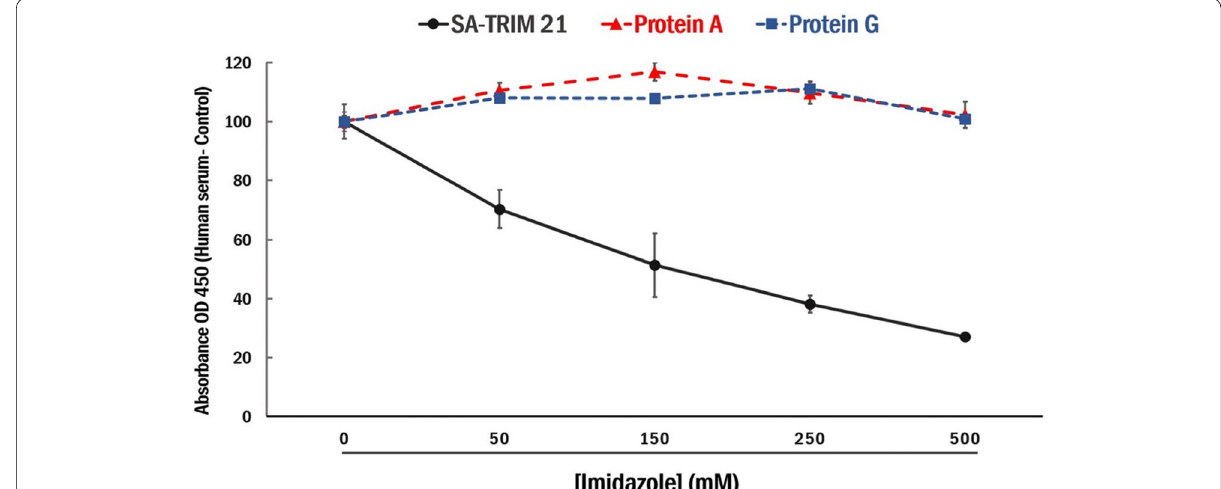
Fig. 8 Impact of imidazole elution on IgG binding. Direct ELISA assays using 50 ng immobilized human serum or 50 ng BSA, followed by SA-TRIM21-HRP (0.5 μg) or HRP-coupled Protein A/G incubation and washing with imidazole-containing buffers. Chromogenic substrate TMB was added to the wells, incubated for 10 min, followed by the addition of 50 μL H 2SO4 and OD450 reading. The data shows the ratio of serum/control OD450 reading. Experiments were performed in triplicates, and error bars represent standard deviation